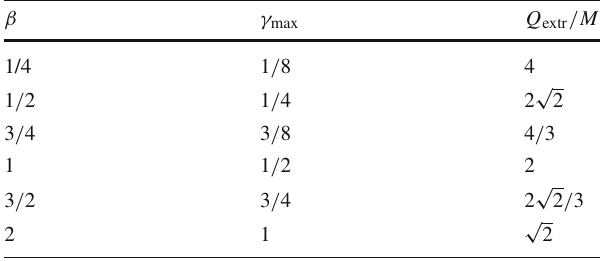
Table 1 The extreme BH charge and maximum value of γ for different values of the parameter